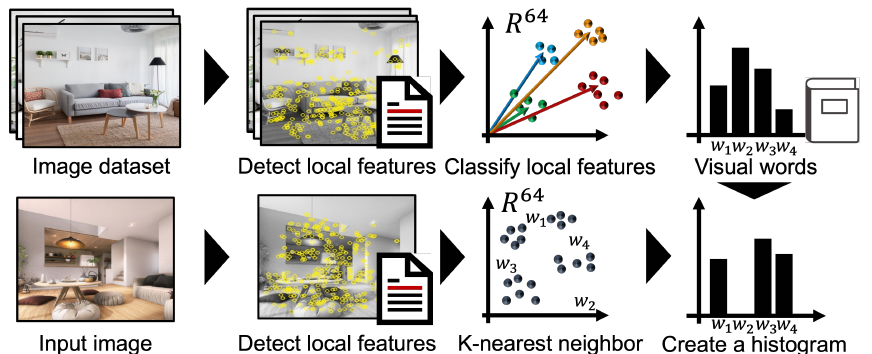
Figure 1. Overview of BoVW.